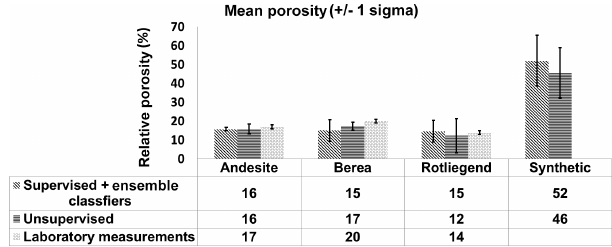
Figure 10. Mean porosity value obtained using supervised and en- semble classifiers as well as unsupervised machine learning tech-